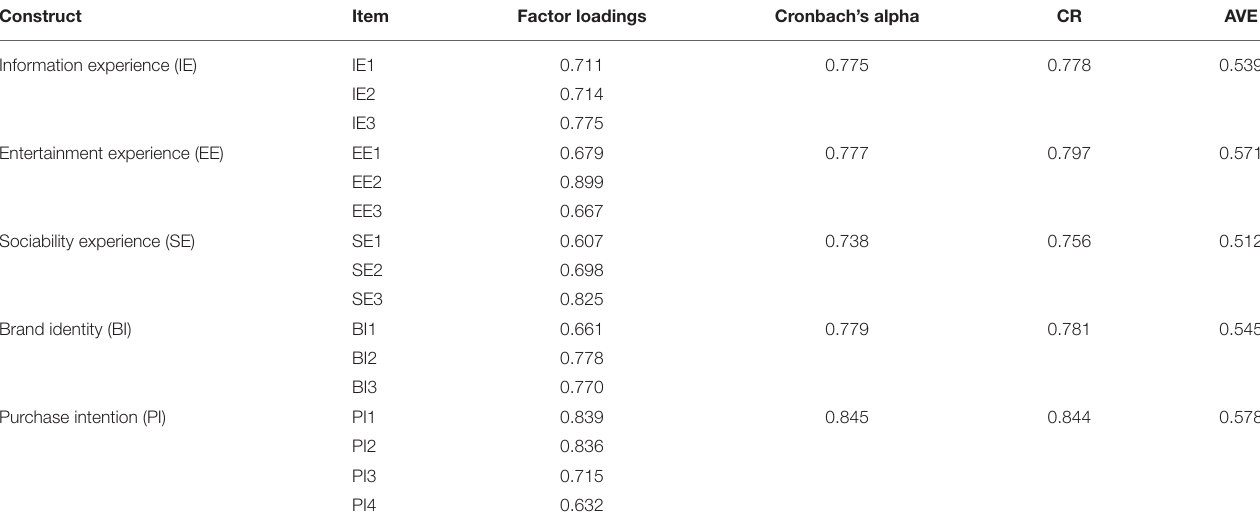
TABLE 2 | Confirmatory factor analysis.